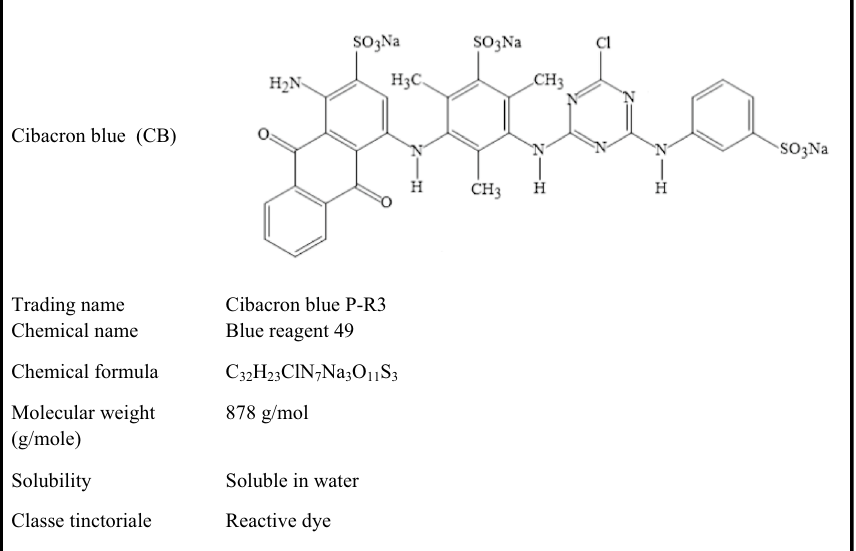
Table 2. The general characteristics of Cibacron